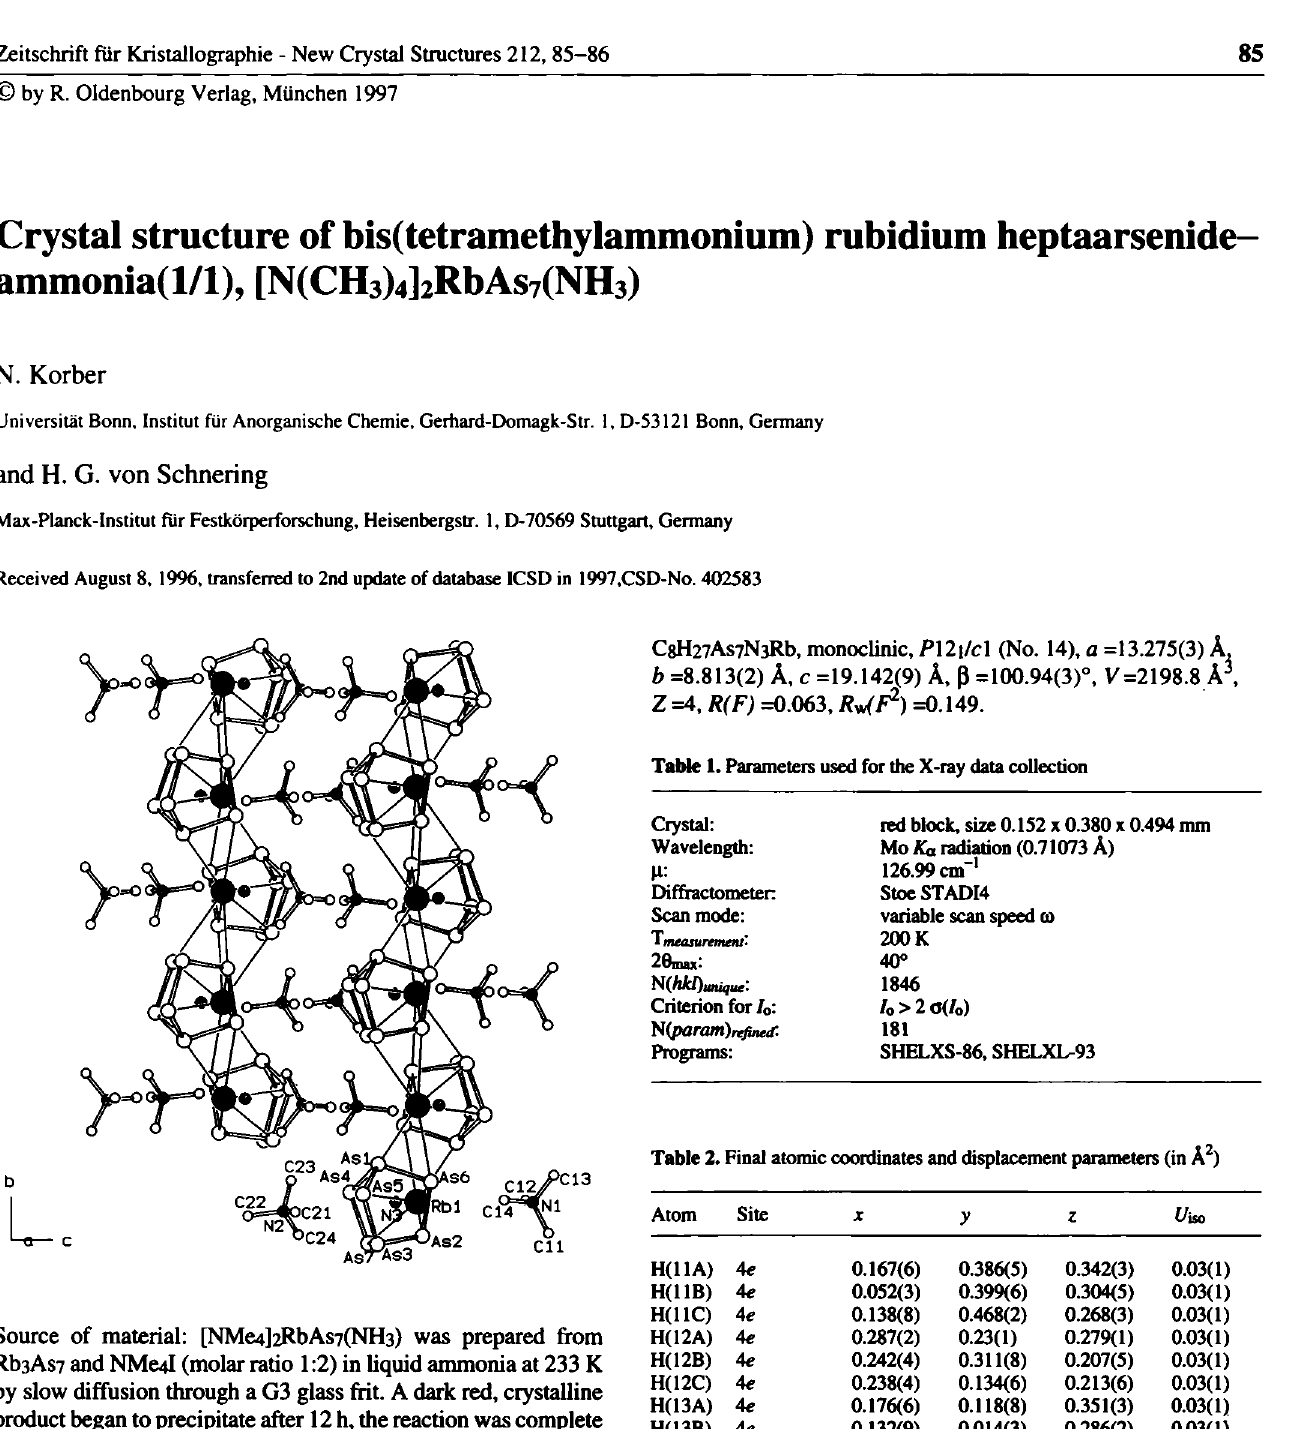
Table 2. Final atomic coordinates and displacement parameters (in Â 2